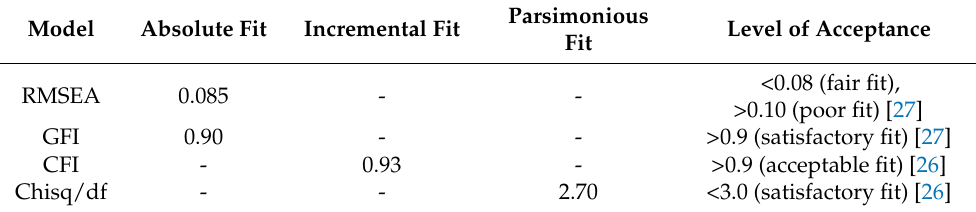
Figure 3. Final questionnaire factor structure model by AMOS SPSS. Table 2. Summary of the Screen Dependency Scale’s goodness of